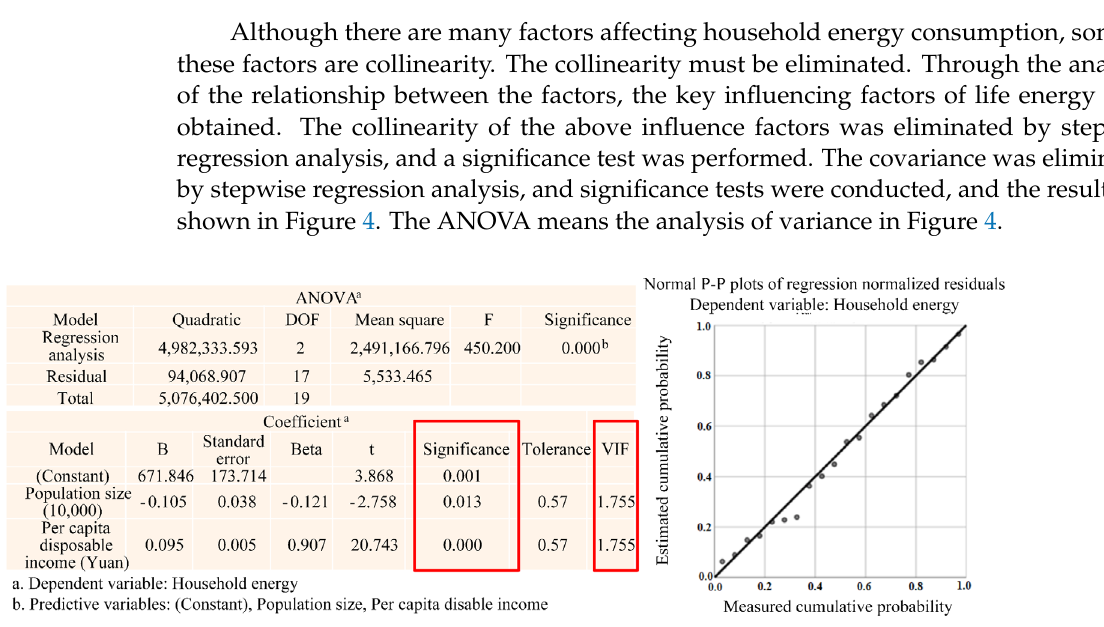
Figure 4. Multiple linear stepwise regression analysis of rural household energy consumption.